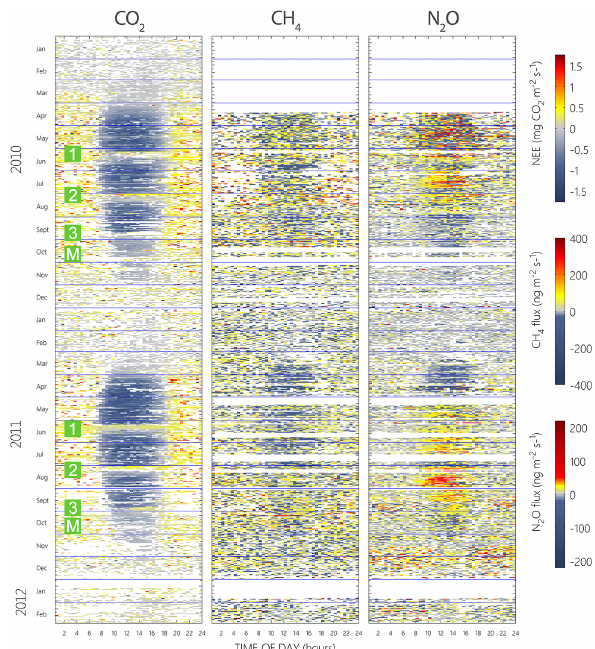
Figure 3. Half-hourly CO 2 , CH 4 and N 2 O fluxes over 2 years of GHG flux measurements. The numbers 1, 2 and 3 in green squares indicate the first, second and third cutting of the meadow, respec- tively, while M denotes manure spreading. Horizontal blue lines show the start and end of months. White color marks missing